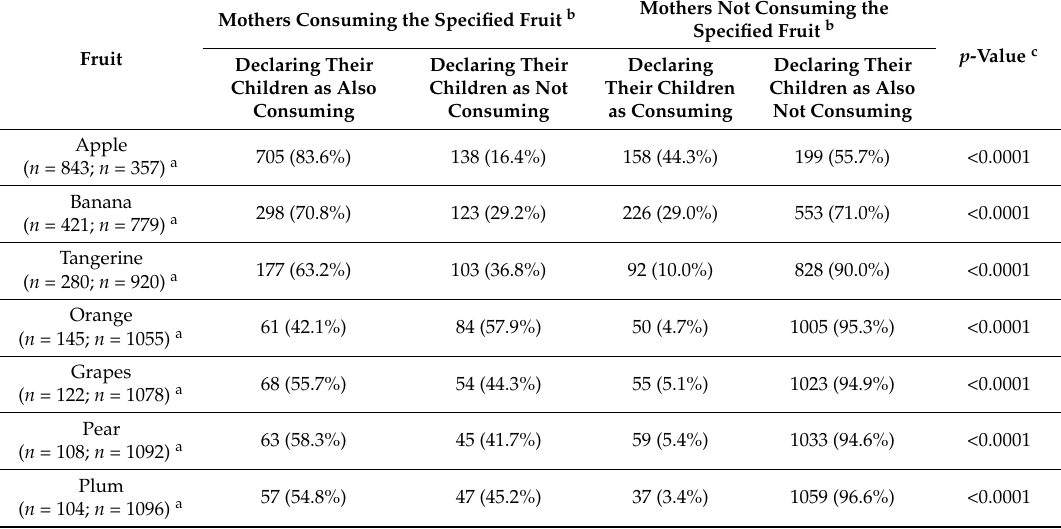
Table 1. Analysis of the association between the fruit consumption behaviors of mothers and their declared fruit consumption behaviors of their children in a national sample of Polish respondents ( n =